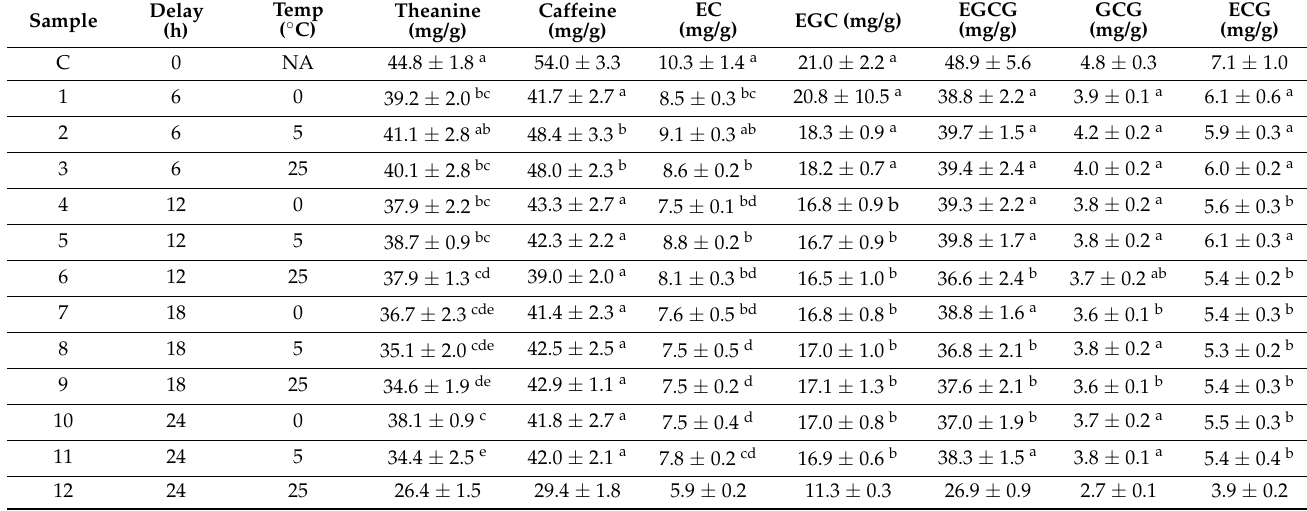
Table 1. The total concentration of target constituents (mean ± SD) of green tea plant material subject to various time and temperature processing delay conditions.